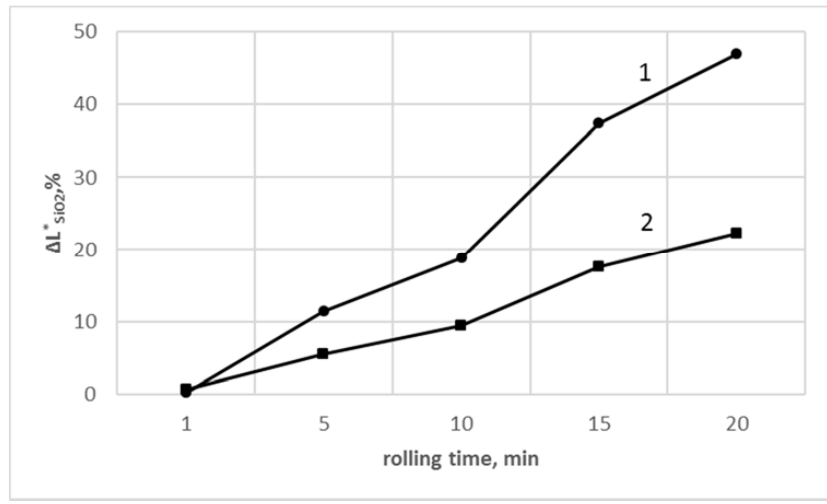
Figure 4. The relative change, Δ L* SiO2 (%), values of SiO 2 -modified PVC vs. unmodified PVC, as a function of rolling time: (1) PVC C /SiO 2 vs. PVC C ; (2) PVC R /SiO 2 vs. PVC R .